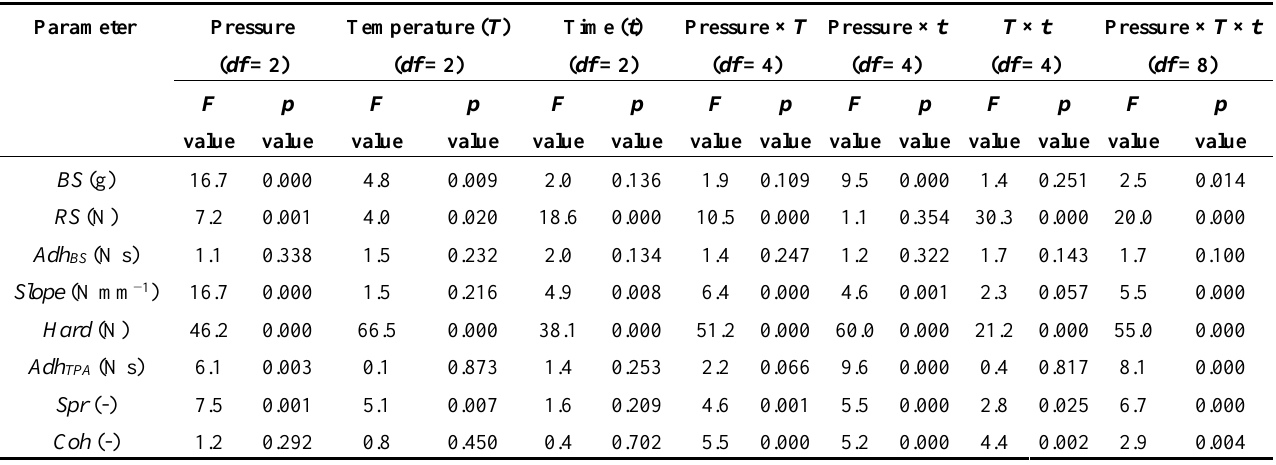
Table 4. Three-way analysis of variance of the textural properties of CF gel heat-induced from pressurized powder form after cooling to 25 °C (high hydrostatic pressure treatments: 200, 400, and 600 MPa, 10, 25, and 50 °C, 5, 15, and 25 min, and unpressurized sample). F and p